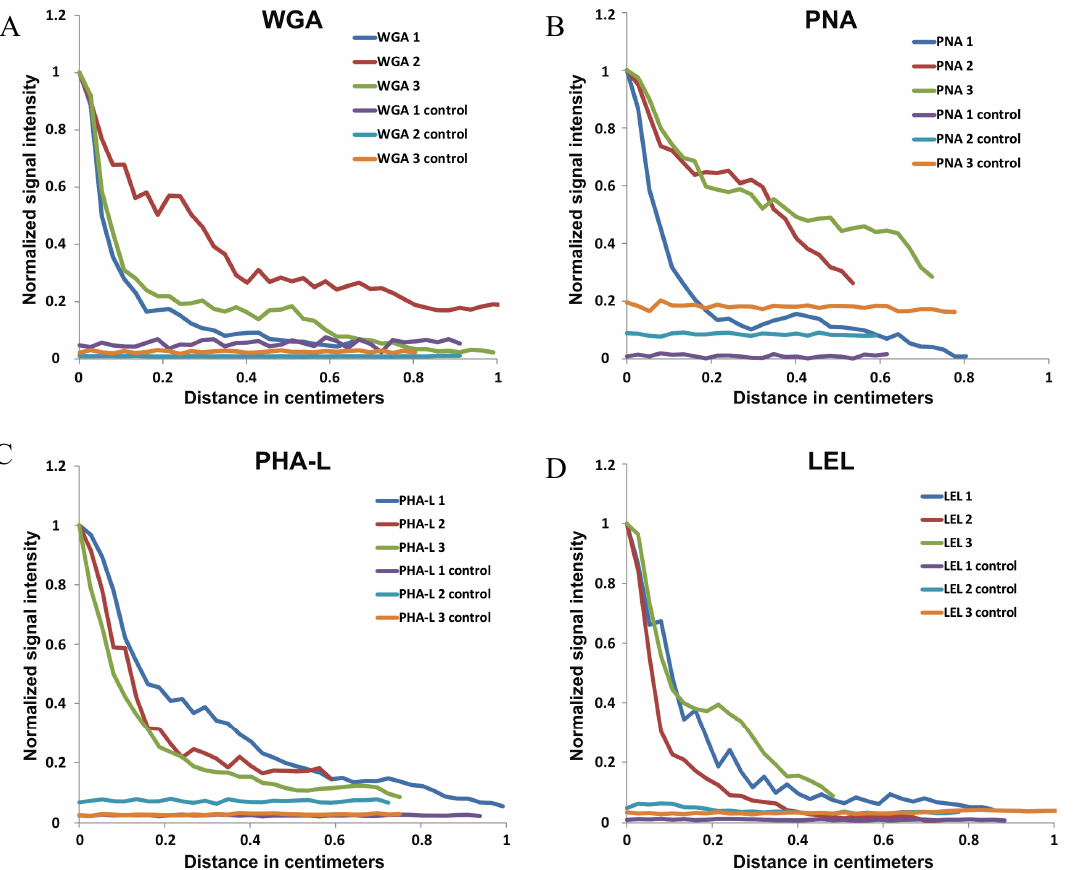
Figure 4. Migration curves. Normalized curves of ( A ) WGA, ( B ) PNA, ( C ) PHA-L and ( D ) LEL show the migration of the lectins along the individual nerves. On the y-axis the normalized intensity signal is depicted, on the x-axis the migration distance